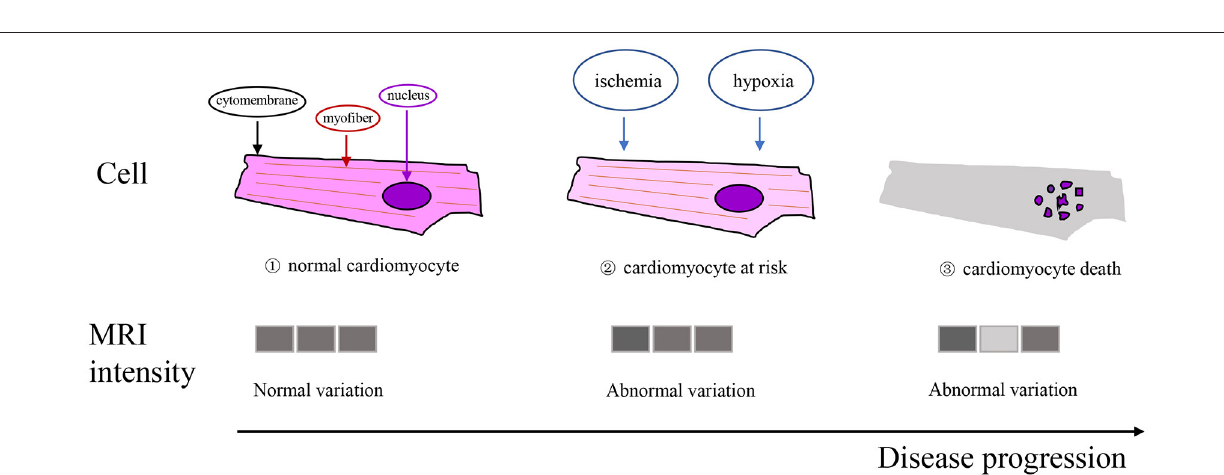
FIGURE 1 | The “wavefront” of myocardial ischemic necrosis, necrosis of cardiomyocytes progresses from the subendocardium to the subepicardium over time if ischemia persists and ultimately becoming transmural infarct.